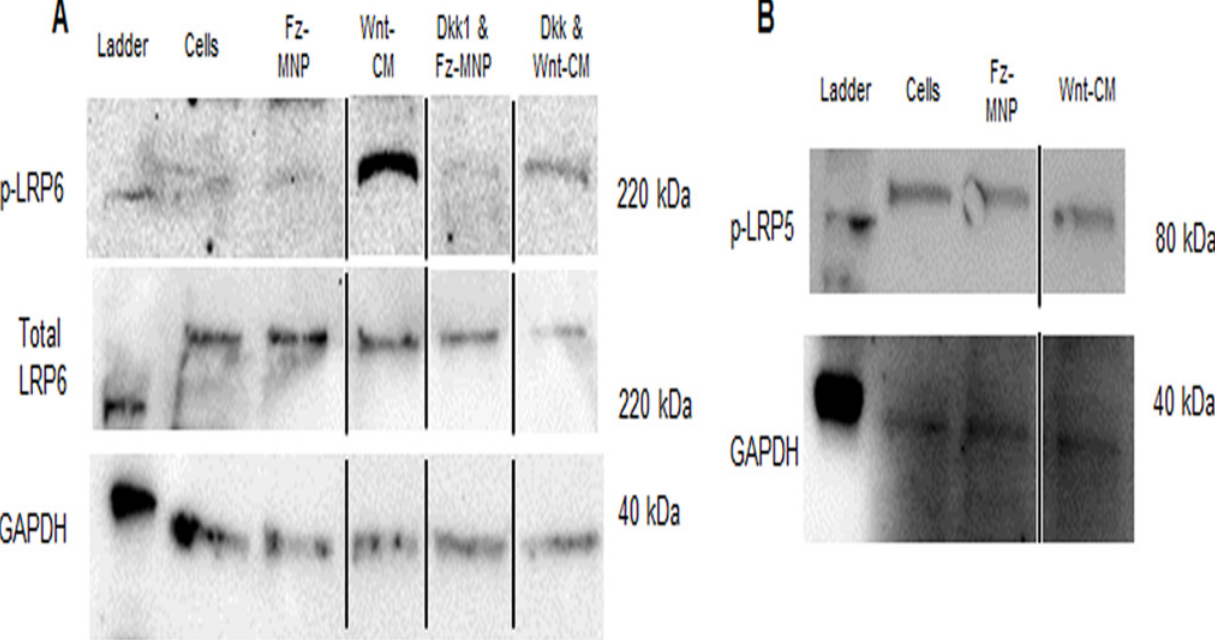
Fig 3. Fz-MNP signal through an LRP Independent mechanism. Treatment of hMSC with Frizzled-particles (Fz-MNP) did not result in phosphorylation of Wnt co-receptor LRP6. In contrast treatment with Wnt conditioned media (Wnt-CM) resulted in clear LRP6 phosphorylation which was blocked using the Wnt inhibitor Dickkopf related protein 1 (Dkk1). Non-treated cells displayed a basal level of Wnt co-receptor LRP5 phosphorylation (B). Treatment with Frizzled particles (Fz-MNP) or Wnt conditioned media (Wnt-CM) had no observable effect on the phosphorylation levels of LRP5. Black lines denote none adjacent